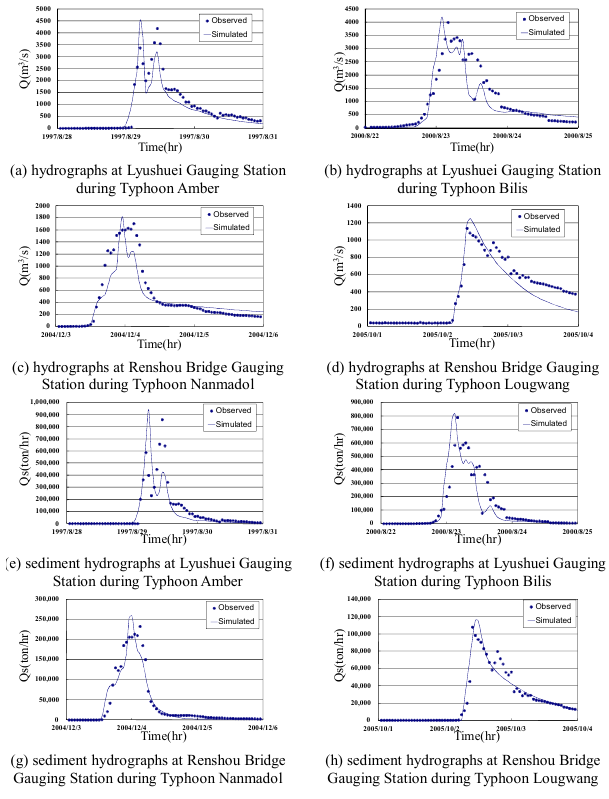
Figure 6. Comparisons of recorded and HSPF simulation results. 610 611 Fig. 6. Comparisons of recorded and HSPF simulation results.